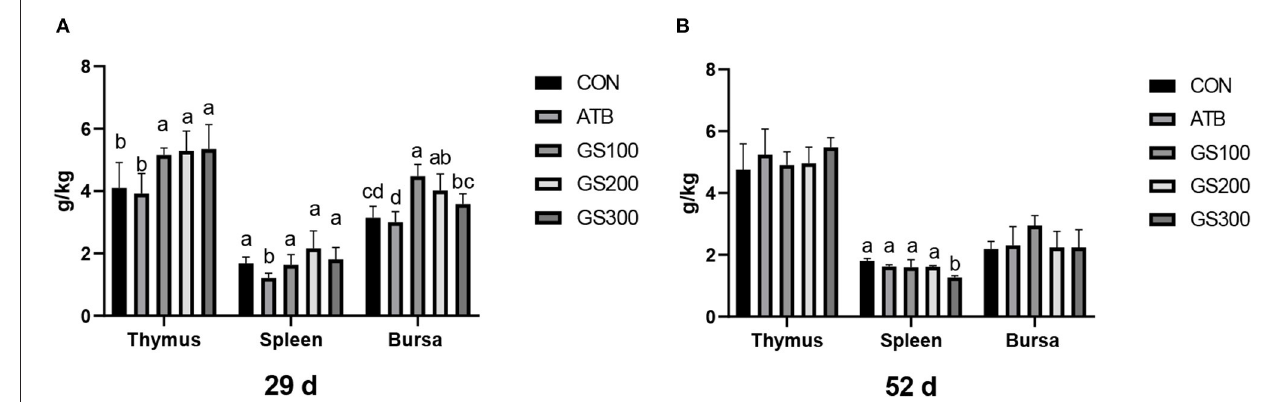
FIGURE 2 | Effects of ginsenoside Rg1 on immune organ index at day 29 (A) and day 52 (B) in broiler chickens ( n = 6). CON, birds fed a basal diet; GS100, birds fed a basal diet supplemented with 100 mg/kg ginsenoside Rg1; GS200, birds fed a basal diet supplemented with 200 mg/kg ginsenoside Rg1; GS300, birds fed a basal diet supplemented with 300 mg/kg ginsenoside Rg1; ATB, a basal diet supplemented with 300 mg/kg chlortetracycline. Data were shown as means ± standard deviations. Mean value without the common letter on the data bar in each figure indicated that the difference was significant ( P < 0.05).